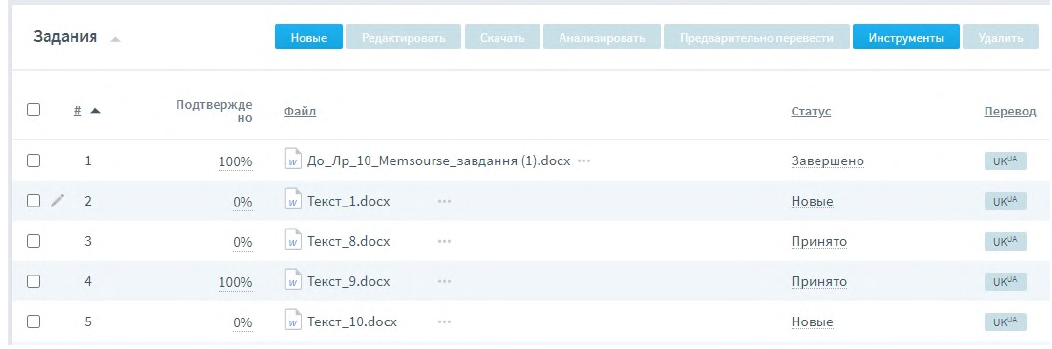
Figure 3: Allocating tasks between project implementers in the Memsource